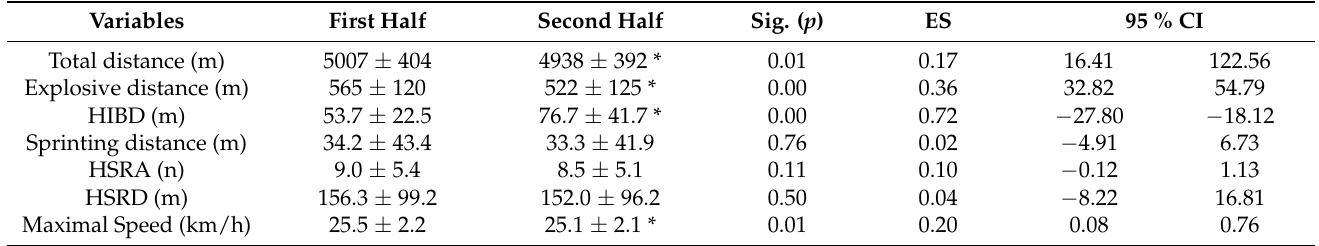
Table 1. External load variables related to distance covered in elite football matches by female field referees.